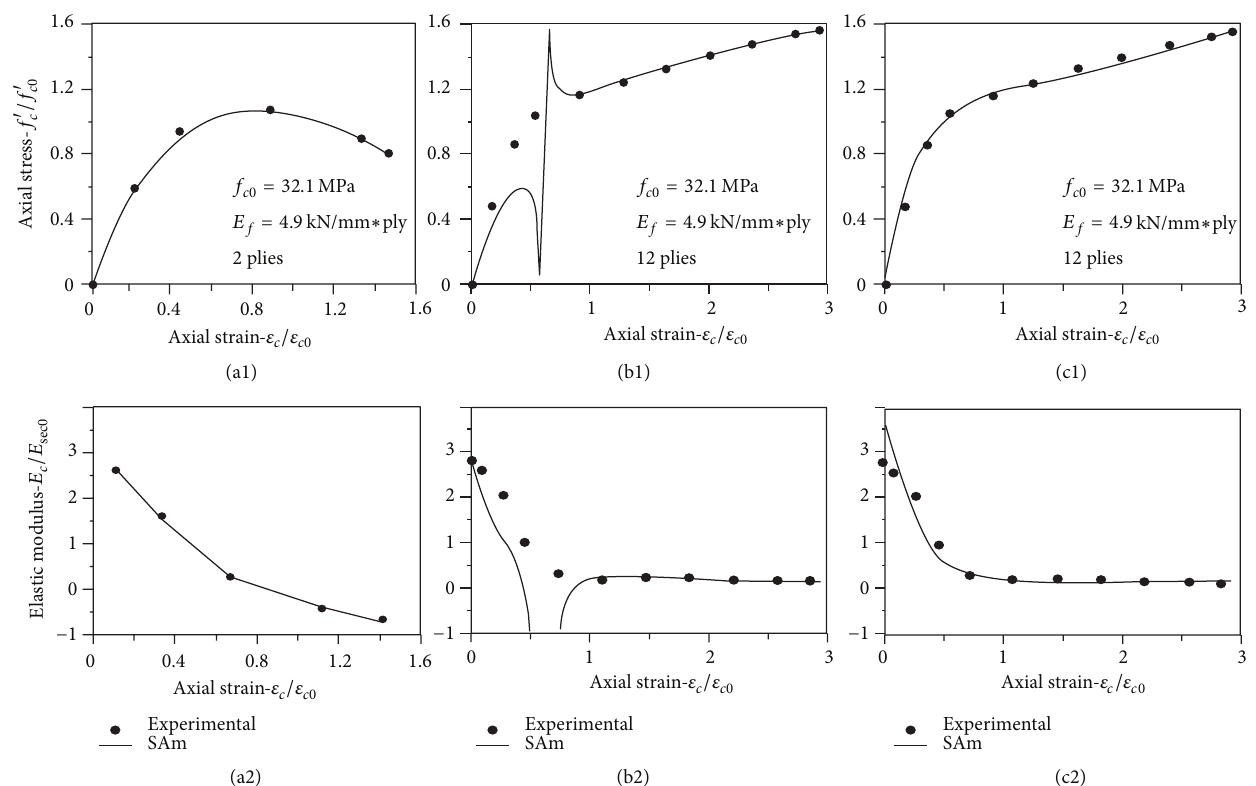
Figure 3: Accuracy of modified Sargin’s model (SAm): eee experimental curve; — SAm